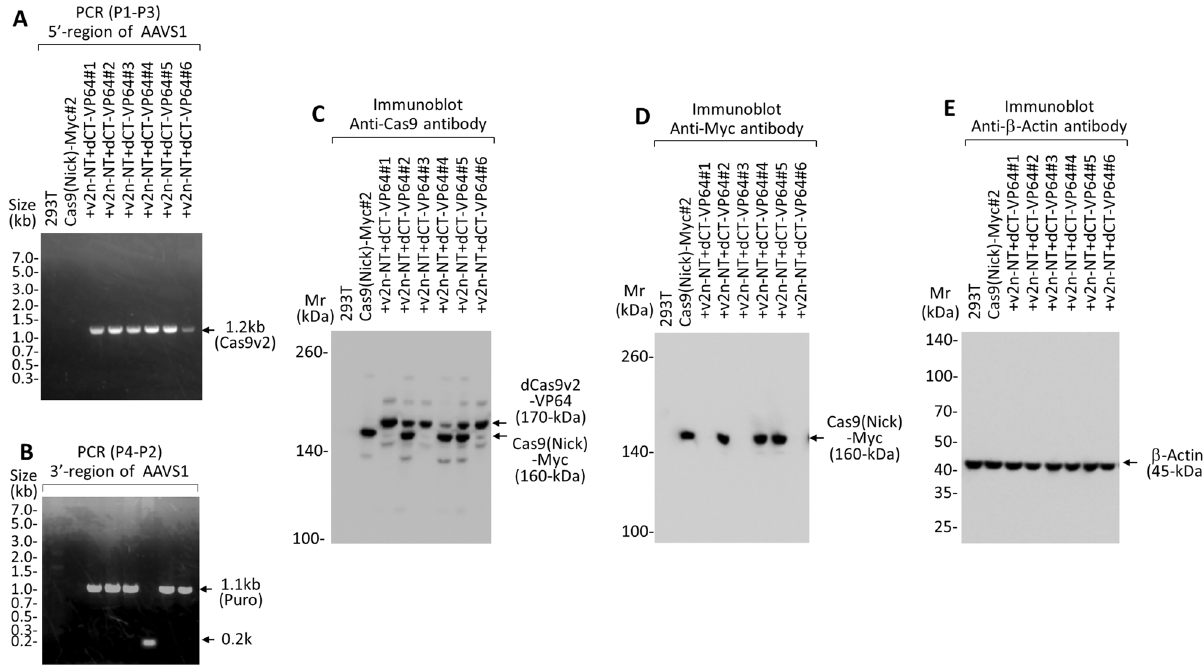
Figure 10. PCR and immunoblot analysis to confirm the reconstitution of full-length dCas9v2-VP64 in the AAVS1 locus. ( A , B ) PCR analysis of genomic DNA prepared from HEK293T, HEK293T-Cas9(Nick)-Myc, and HEK293T-Cas9(Nick)-Myc + v2n-NT + dCT-VP64 #1–#6 cells, after sequential infections of AAV vectors #7 and #9, as in Fig. 8B. v2n-NT, 1.9 kb Cas9v2 nickase-NT; dCT-VP64, 2.3 kb dCas9v2-CT-VP64. Primers P1–P3 (Cas9v2), and P4–P2 (Puro), were used to examine the integration efficiency of the reconstituted full-length dCas9v2-VP64 into the AAVS1 locus at the 5 ′ - and 3 ′ -regions. ( C – E ) Lysates obtained from the same cells used for the PCR analysis were analyzed using immunoblot, with the antibodies indicated. Arrows indicate reconstituted full-length dCas9v2-VP64 (170 kDa), lentiviral Cas9 (Nick)-Myc (160 kDa), and β-actin (45